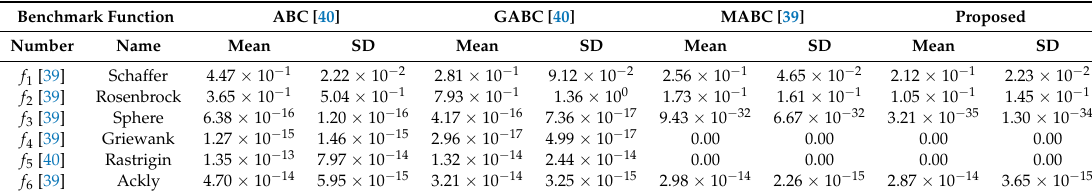
Table 2. Comparison of the obtained results for benchmark functions.